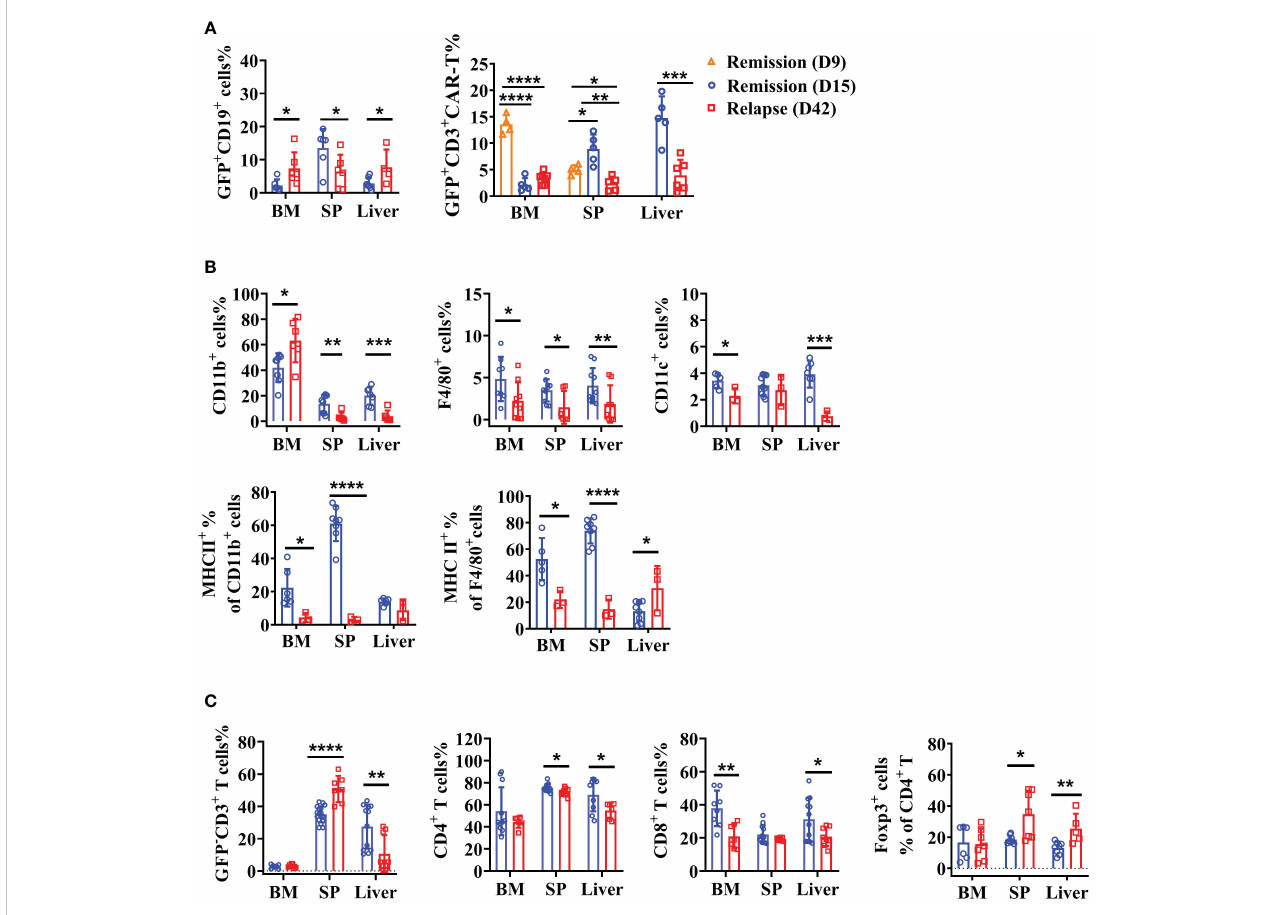
FIGURE 6 Recession of the intrinsic immune response with enhanced immunosuppression of TME in relapsed mice. After anti-CD19 CAR T-cell treatment for 15 and 42 days, lymphoma mice were in the remissive and relapsed stages, respectively. (A) The percentages of A20 and anti-CD19 CAR T cells were shown. (B) The quantity and expression of activation markers on myeloid cells were detected by fl ow cytometry. (C) The percentage of T-cell subsets. Two independent experiments were repeated. Data were mean ± SD and compared using unpaired Student ’ s t-test. * P < 0.05, ** P < 0.01, *** P < 0.001, **** P <